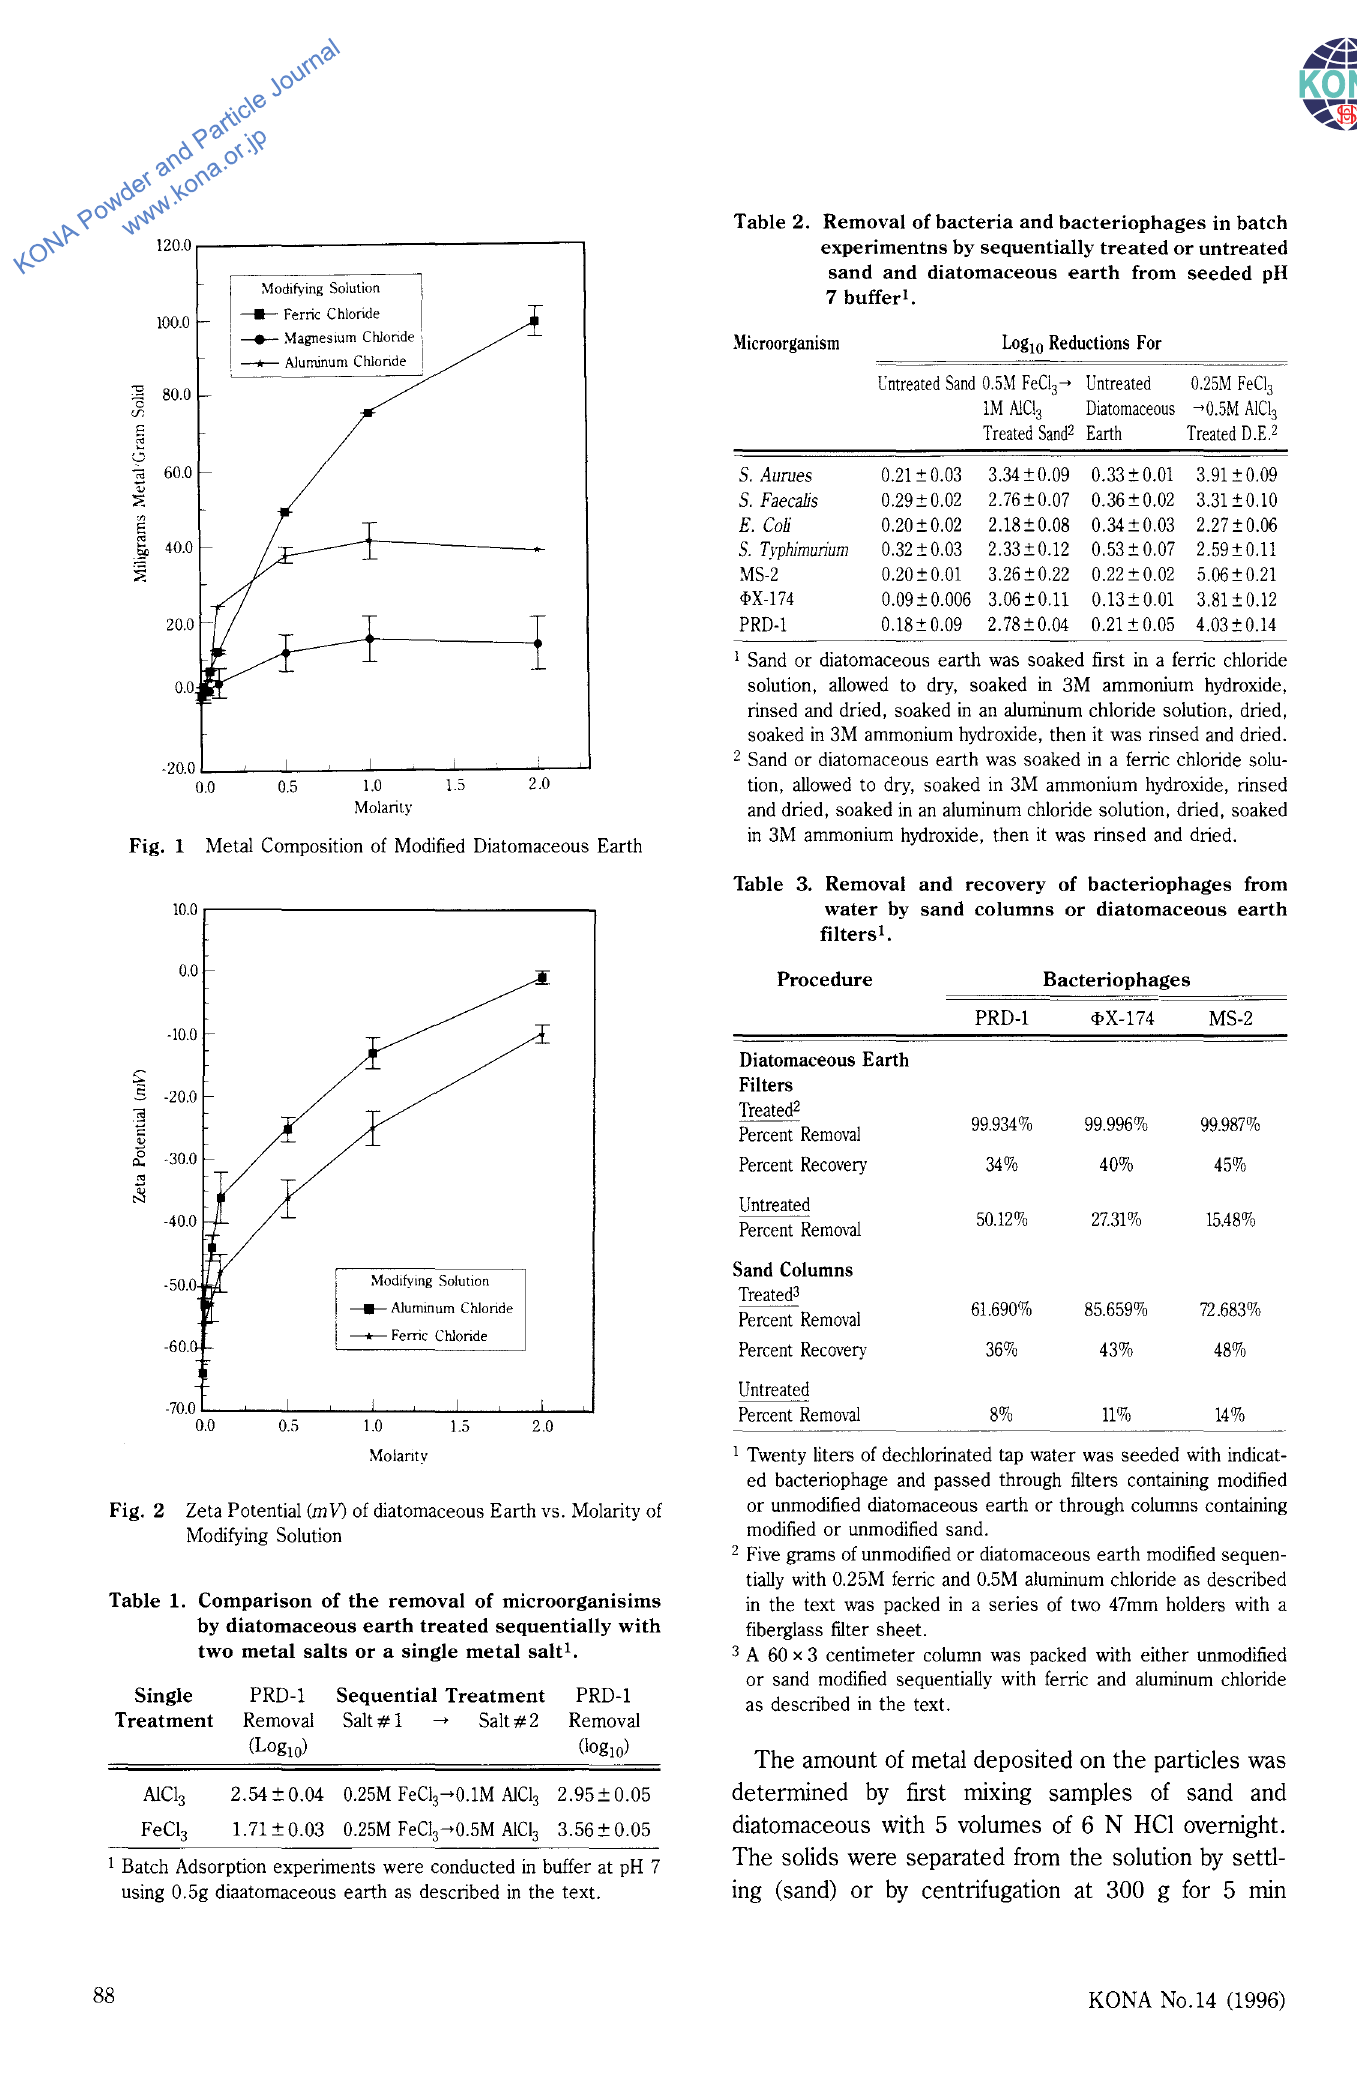
Table 2. Removal of bacteria and bacteriophages in batch experimentns by sequentially treated or untreated sand and diatomaceous earth from seeded pH 7 bufferl.